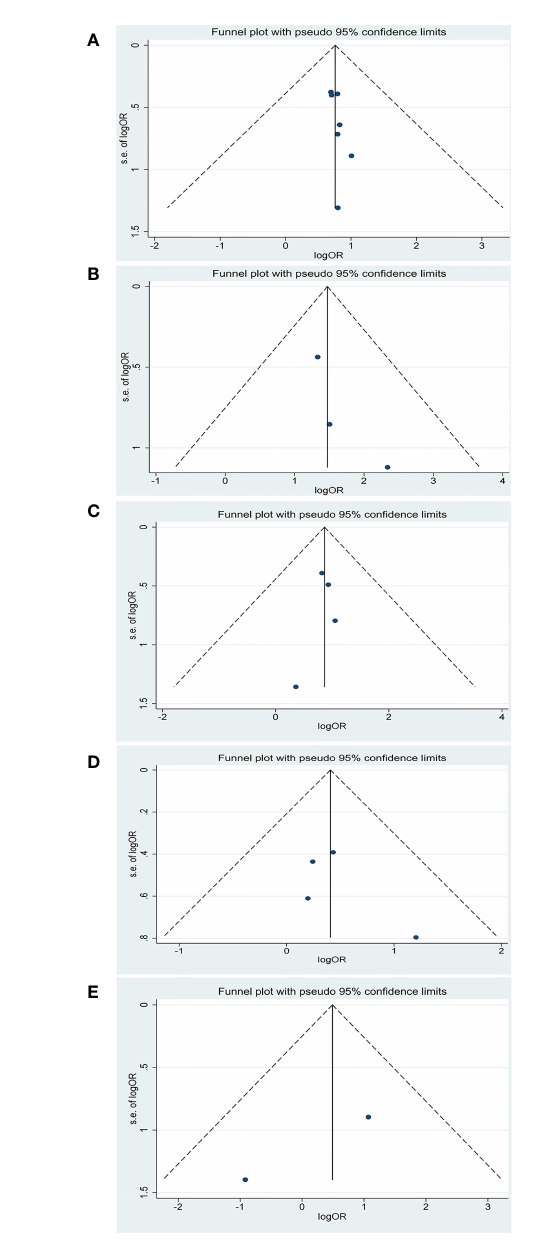
FIGURE 4 Funnel plot of objective response rate (ORR) for studies reporting biomarkers. (A) baseline plasma Epstein-Barr virus (EBV) DNA level; (B) dynamic plasma EBV DNA load during immunotherapy; (C) programmed cell death-ligand 1 (PD-L1) expression (higher vs. lower); (D) PD-L1 expression (positive vs. negative); (E) tumor mutation burden (TMB).